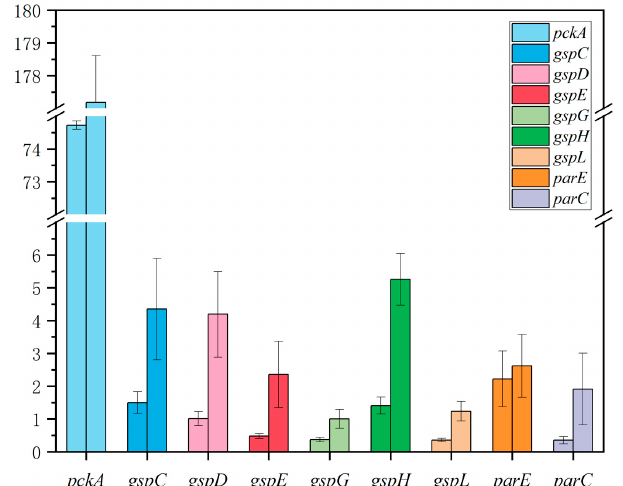
Figure 7. Quantitative reverse transcription polymerase chain reaction of upregulated genes. The left column represents the plankton cells sample, and the right column represents the bio fi lm sample.